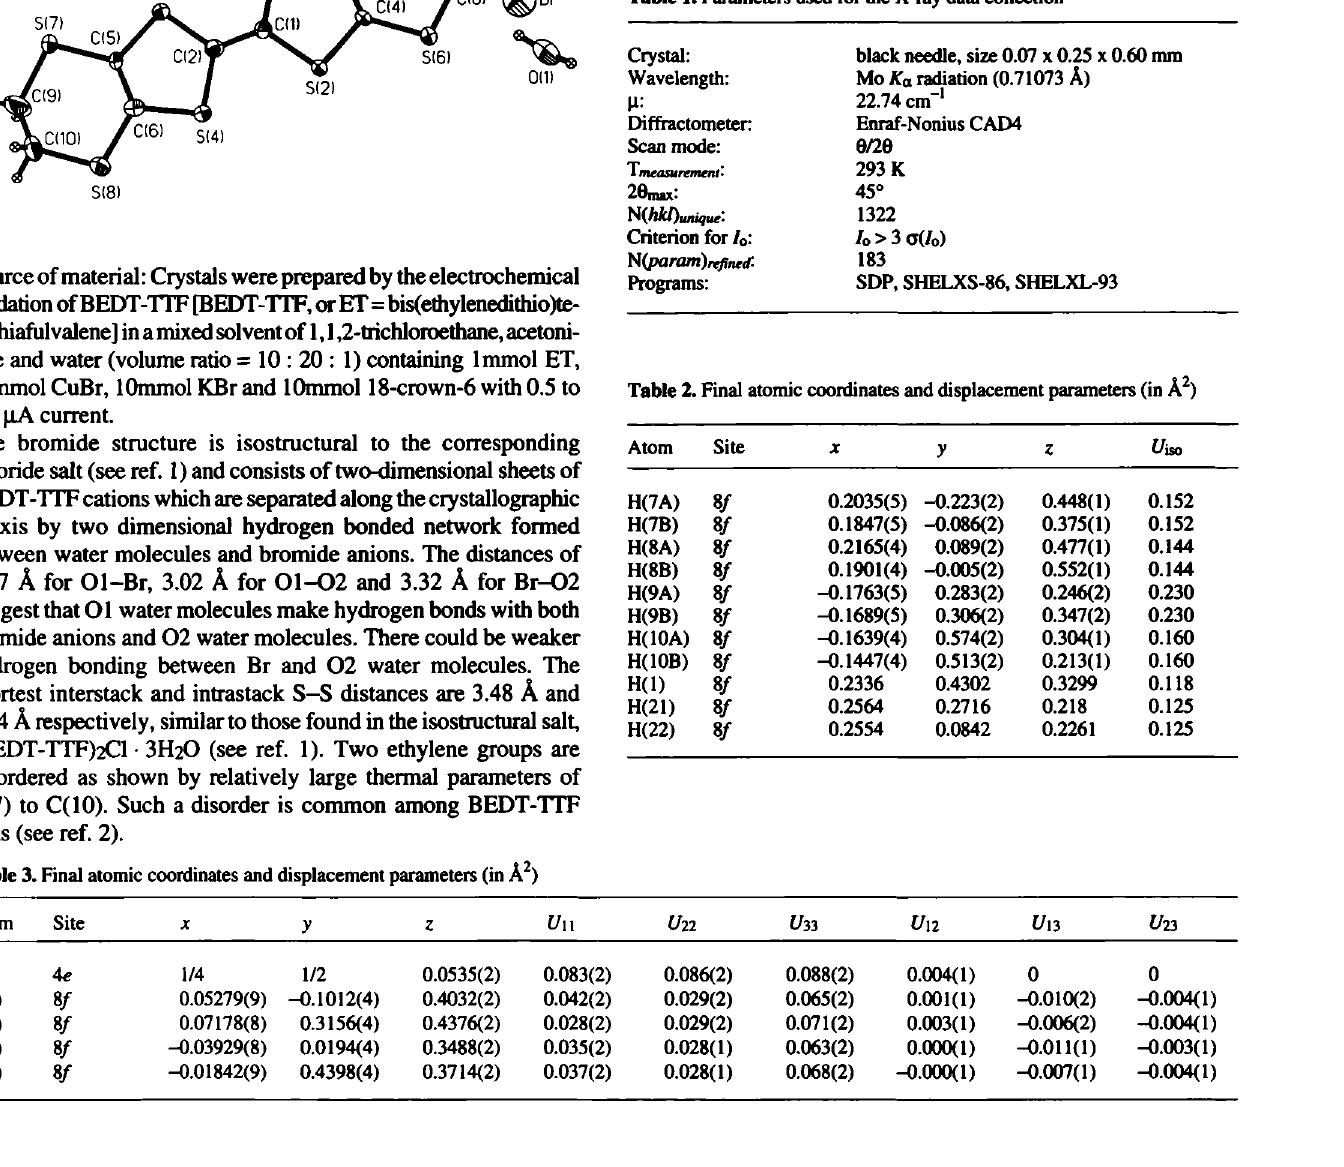
C20H22B1O3S16, orthorhombic, Pcca (No. 54), a =32.83(1) Â,